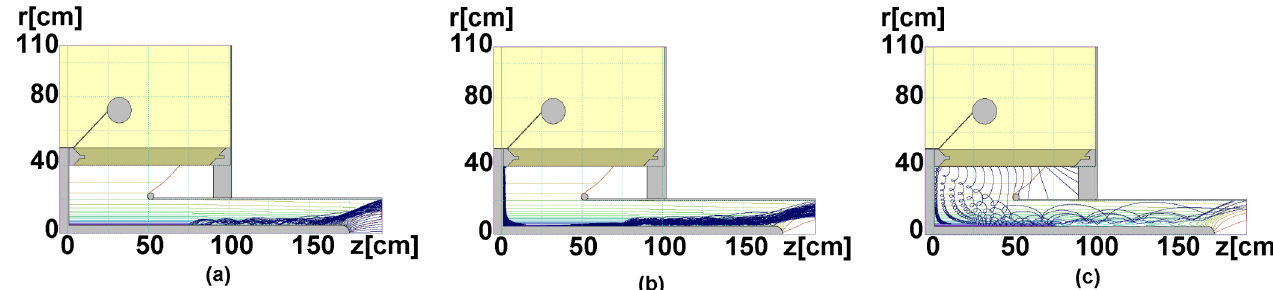
FIG. 14. (Color) Space charge limited emission of an electron beam current from the cathode stalk in (a) generates magnetic and electric fields. In (b) the low current electrons originating on the cathode field-shaping ring and the central stalk are propagated in the presence of the fields generated in (a). In (c) secondaries of the type shown in 12(b) are traced in the presence of these fields.